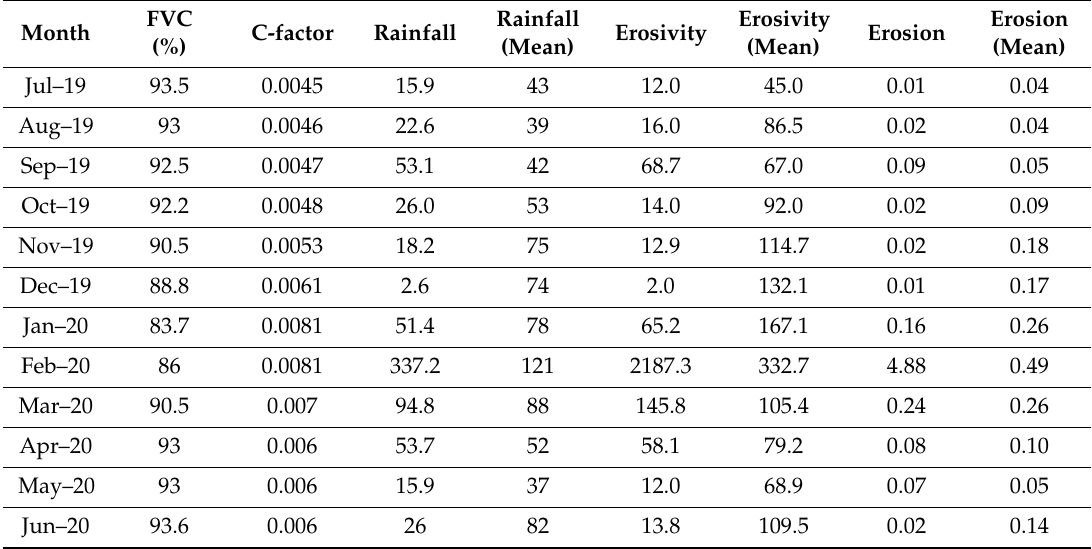
Table 2. Estimated mean monthly erosivity and erosion at Sydney drinking water catchment for the